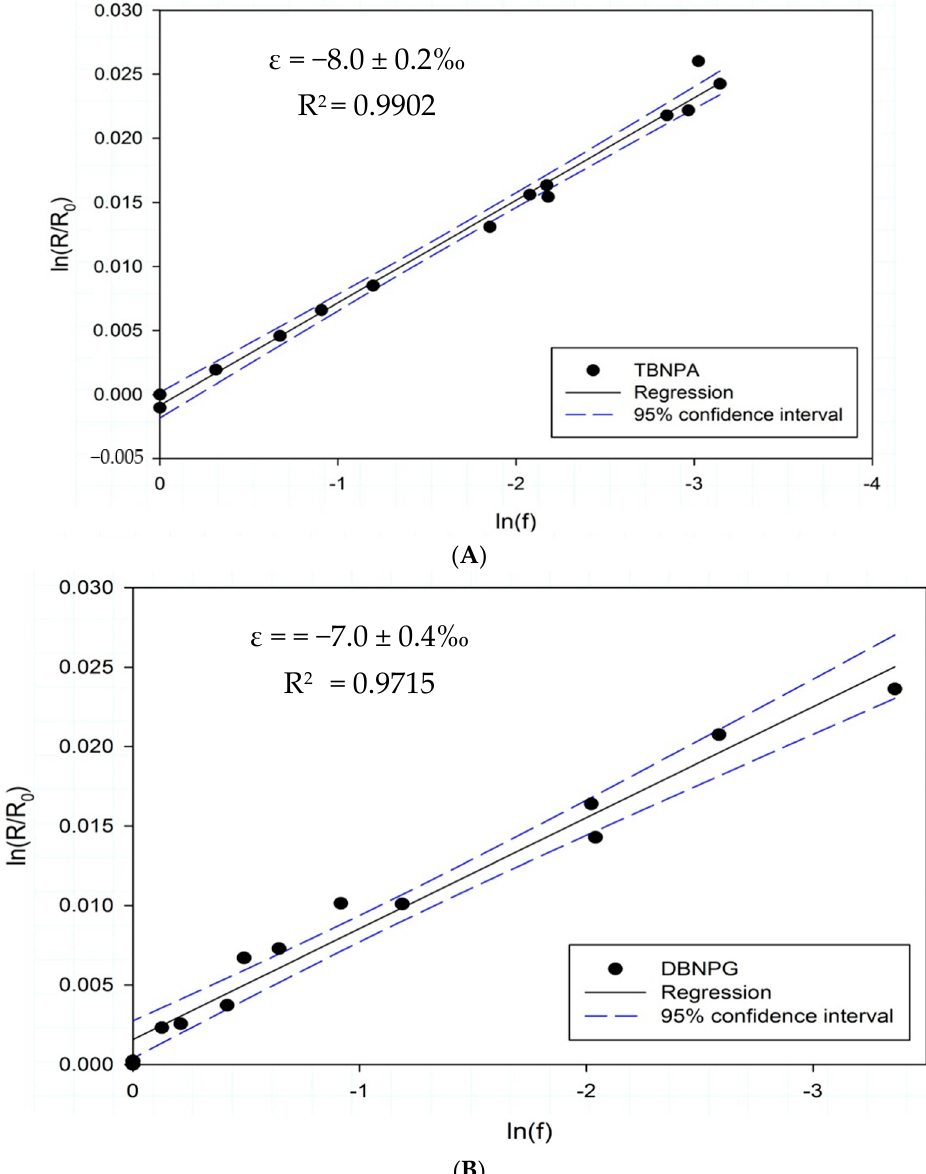
Figure 3. Rayleigh plot for carbon isotopes for ( A ) TBNPA aerobic biodegradation, ( B ) DBNPG aerobic biodegradation. f = fraction of degradation; Rt and Rt 0 , carbon isotope composition of the compound at time t and zero, respectively.